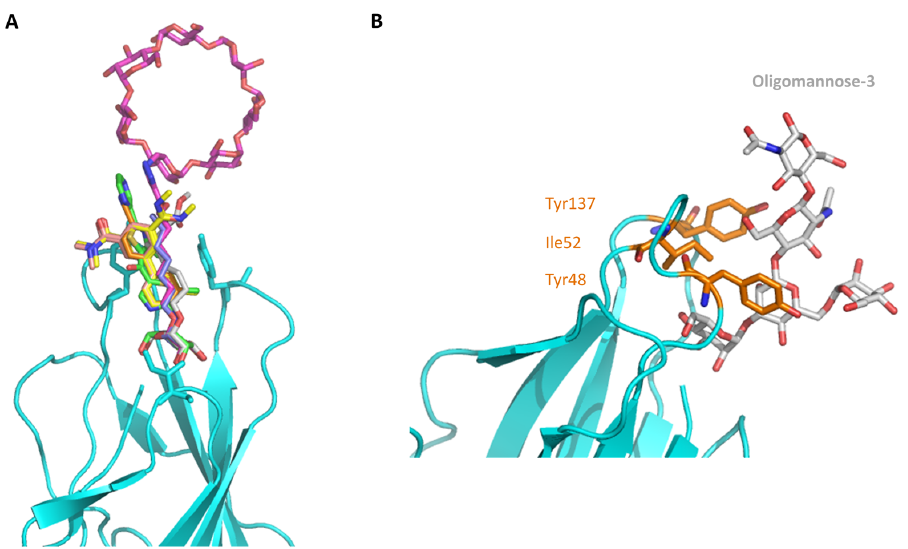
Figure 2. FimH in complex with different inhibitors. ( A ) The mannose ring of different recent high ‐ affinity inhibitors is bound similarly to FimH. Shown are the following inhibitors: HM (lilac, PDB ID: 4BUQ [31]), thiazolylaminomannoside (green; PDB code 5MTS [32], β‐ cyclodextrin ‐α‐ D ‐ mannoside (purple; PDB code 5AB1 [23]), para ‐ biphenyl ‐ 2 ‐ methyl ‐ 3 ′ ,5 ′ di ‐ methylamide ‐α‐ D ‐ mannoside (yellow; PDB 5F2F [33]), 8 ‐ (Methoxycarbonyl)octyl ‐α‐ D ‐ mannoside (grey, PDB code 4AVI [34]), 3 ′‐ Chloro ‐ 4 ′‐ ( α‐ D ‐ mannopyranosyloxy)biphenyl ‐ 4 ‐ carbonitrile (orange, PDB code 4CST [35]), para ‐ biphenyl ‐ 2 ‐ methyl ‐ 3 ′‐ methylamidemannoside (rose, PDB code 5F3F [36]). ( B ) Oligomannose ‐ 3 bound to FimH. The mannoside is highlighted in grey and the tyrosine gate residues in yellow. The FimH lectin domain is shown in cyan in the cartoon (PDB code 2VCO [37]).